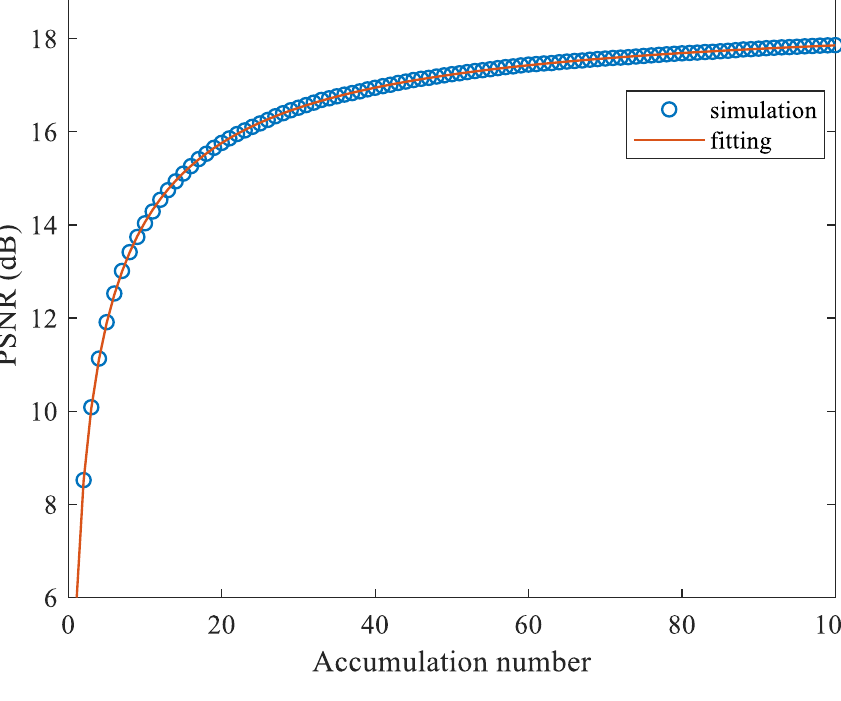
Figure 3. PSNR of the reconstructed image by RP binary CGHs as a function of accumulation number. The values of the parameters ( S , K ) of the fitting curve are (2.04, 17.36).